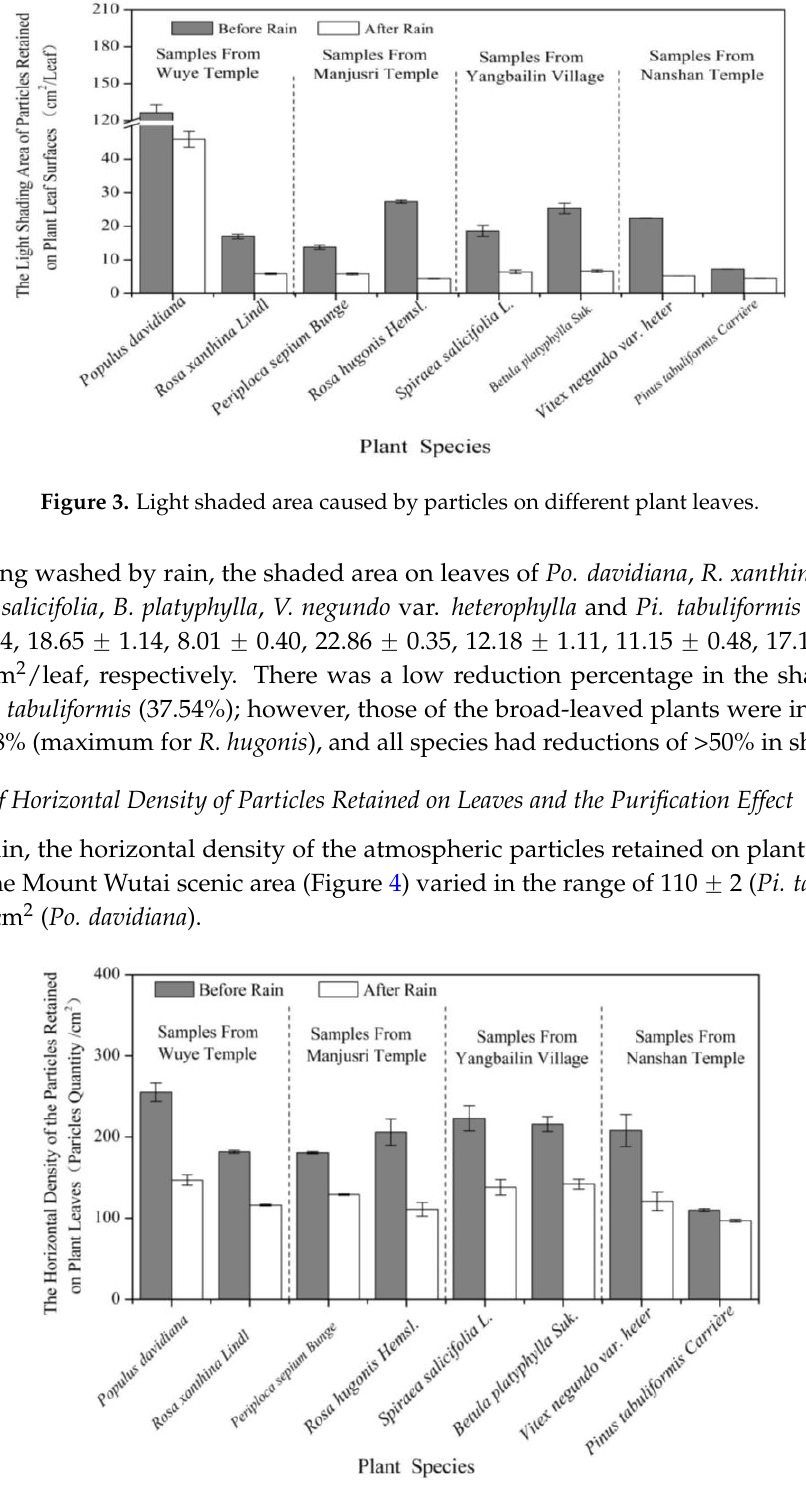
Figure 4. Horizontal density of atmospheric particles on different plant leaves.